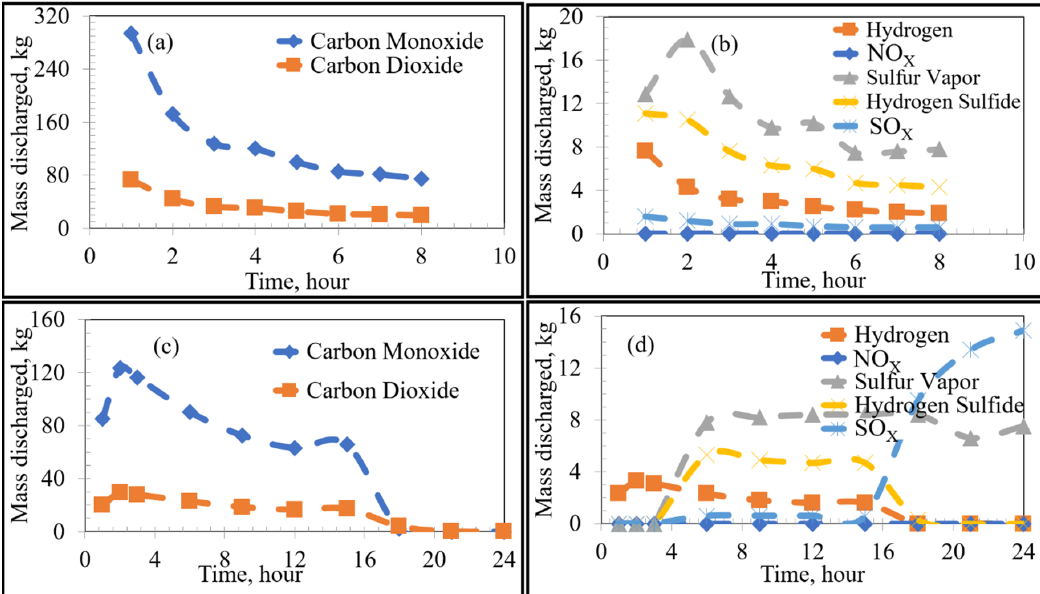
Figure 7 . Emissions under substoichiometric combustion as a function of time: High Sulfur Emission Case; ( a ) and ( b ) show the Current Operation, and ( c ) and ( d ) show the Future Operation.